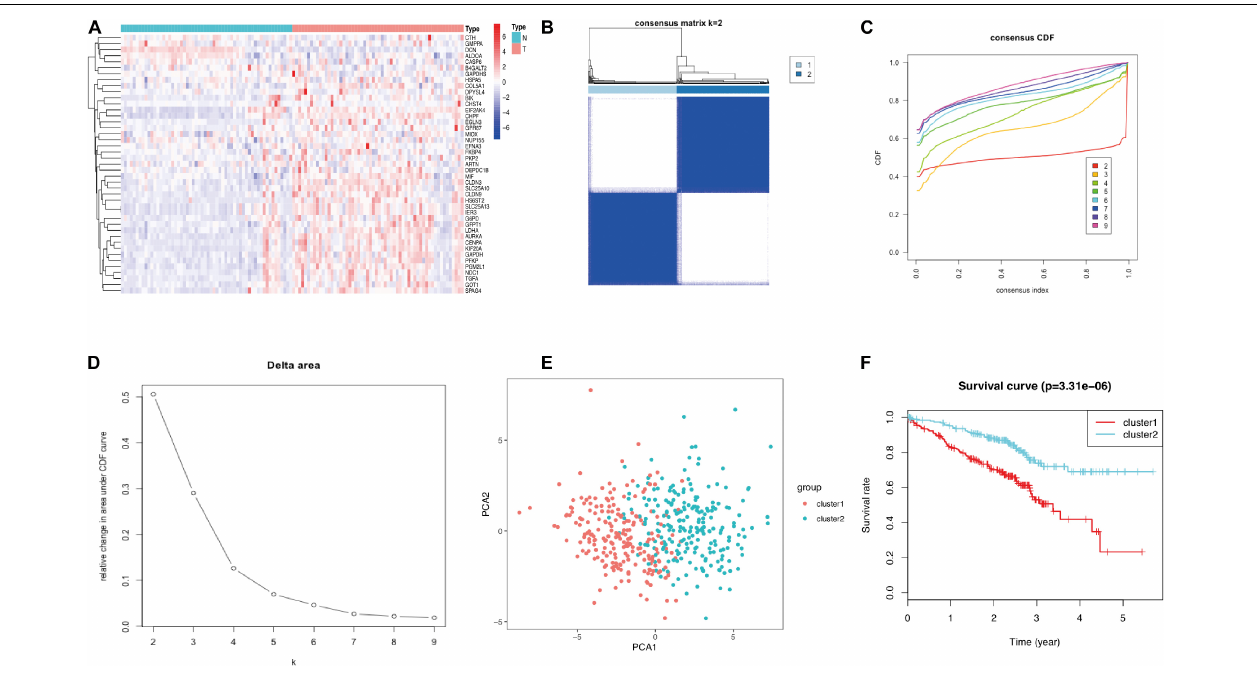
FIGURE 5 | Validation of the gene expression and grouping in GSE72094. (A) Heat map of 43 glycolysis-related genes between LUAD and normal tissue. (B) Consensus clustering matrix for k = 2. (C) Consensus clustering CDF for k = 2–9. (D) Relative change in area under the CDF curve for k = 2–9. (E) PCA of the 43 glycolysis-related genes in LUAD. (F) Survival curves of each cluster in LUAD. LUAD, lung adenocarcinoma; TCGA, The Cancer Genome Atlas; CDF, cumulative distribution function; PCA, principal component